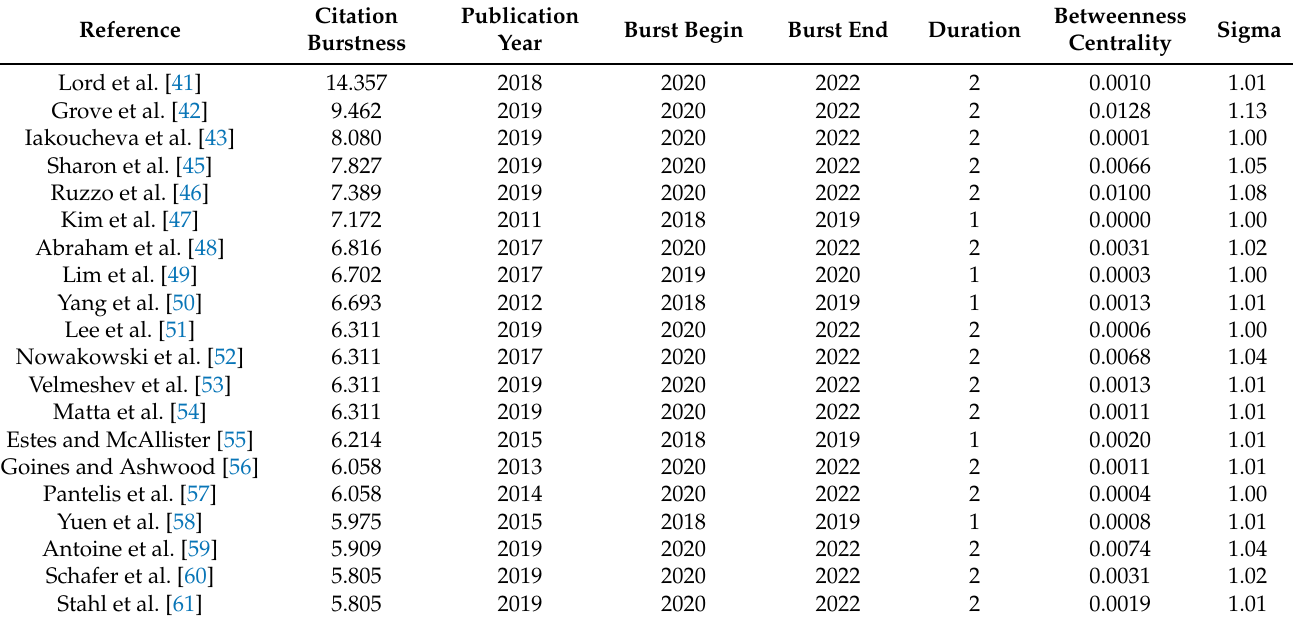
Table 2. Identifying characteristics of 20 documents with higher citation burtness metric generated in the document co-citation analysis